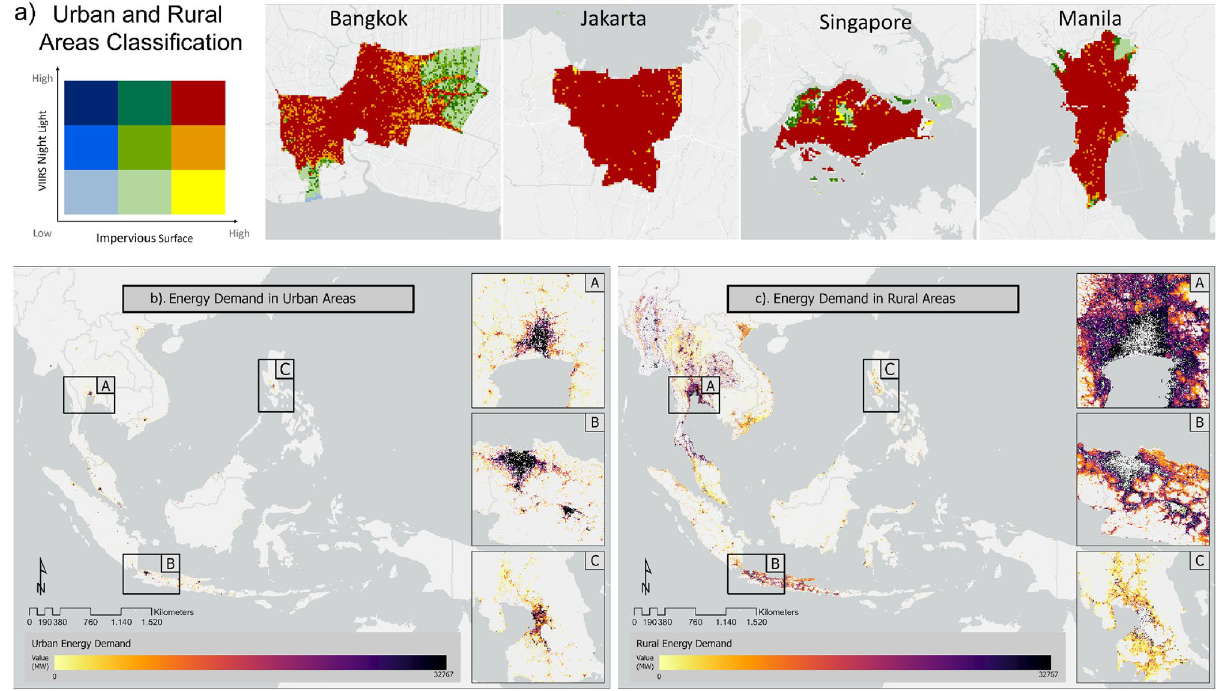
Figure 1. Urban rural area classification in four selected capital city in Southeast Asia ( a ) and total annual energy consumption in ( b ) urban and ( c ) rural areas. The insets represent the metropolitan areas of ( A ) Bangkok, Thailand, ( B ) Jakarta, Indonesia, and ( C ) Manila, Philippines.